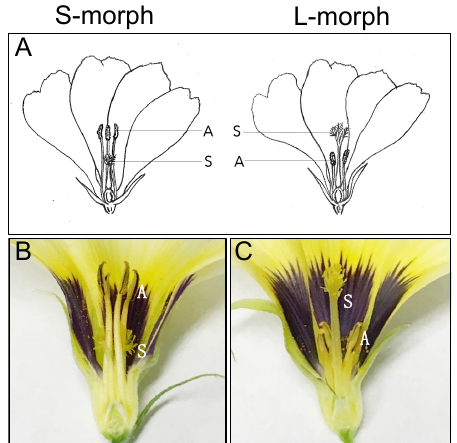
Figure 1. Phenotypes of short (S-morph) and long (L-morph) style morphs. ( A ) Diagram showing reciprocal arrangement of stigma and style (S) and anthers and stamens (A). ( B , C ) Longitudinal section of a mature flower showing the short morph and long morph of Turnera subulata.